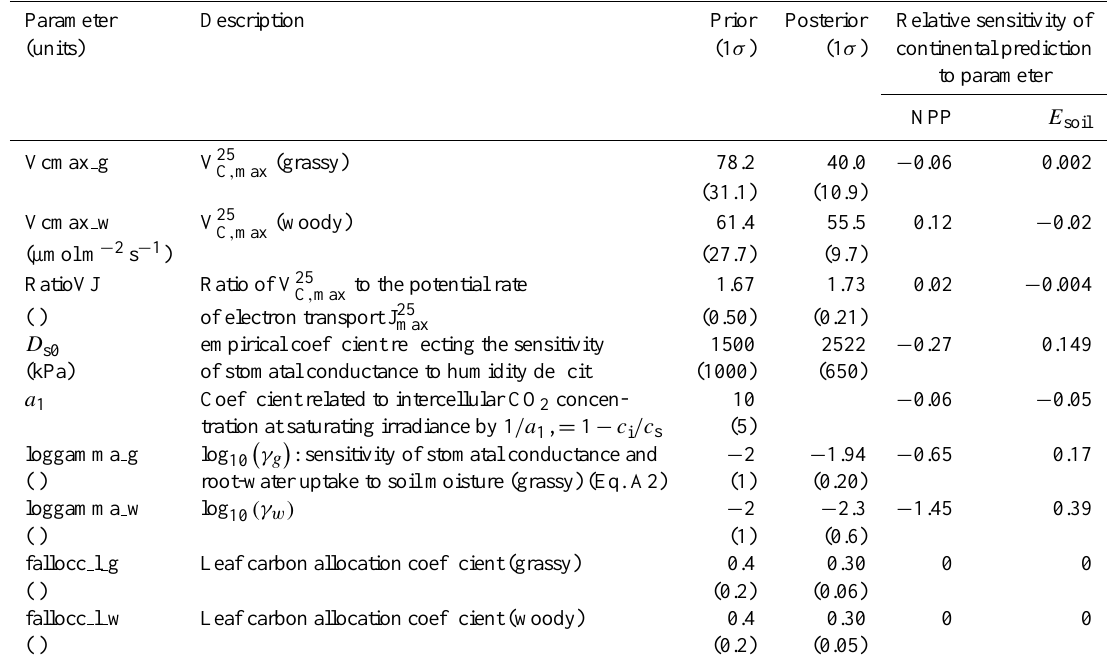
Table A2. Prior and posterior values of target parameters in CABLE-SLI, and relative sensitivities of continental NPP and soil evaporation to